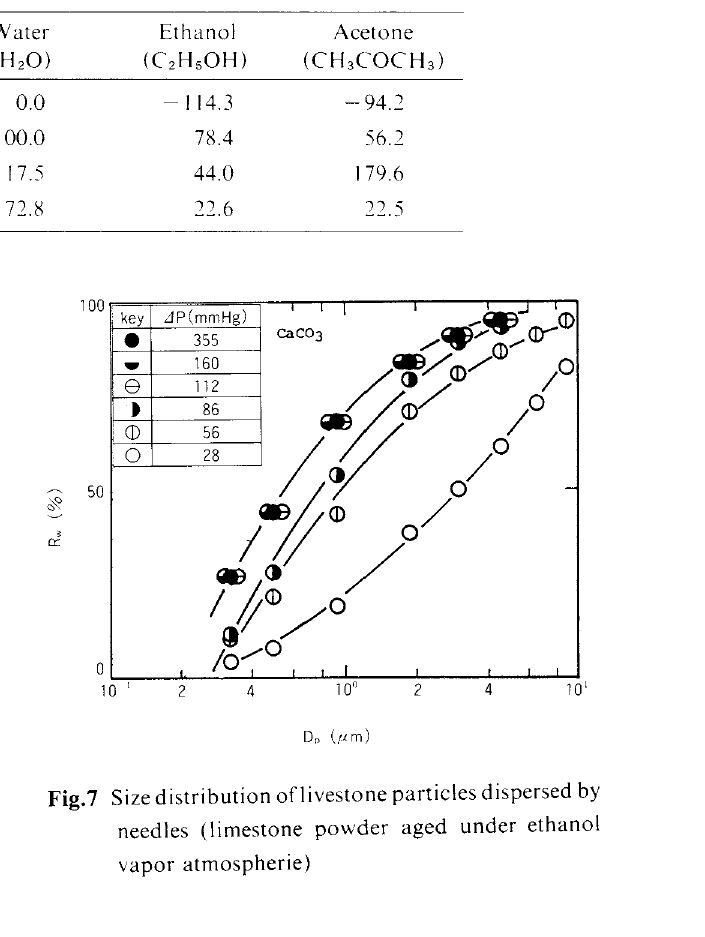
Physical properties of dispersing aids (at 20°C)